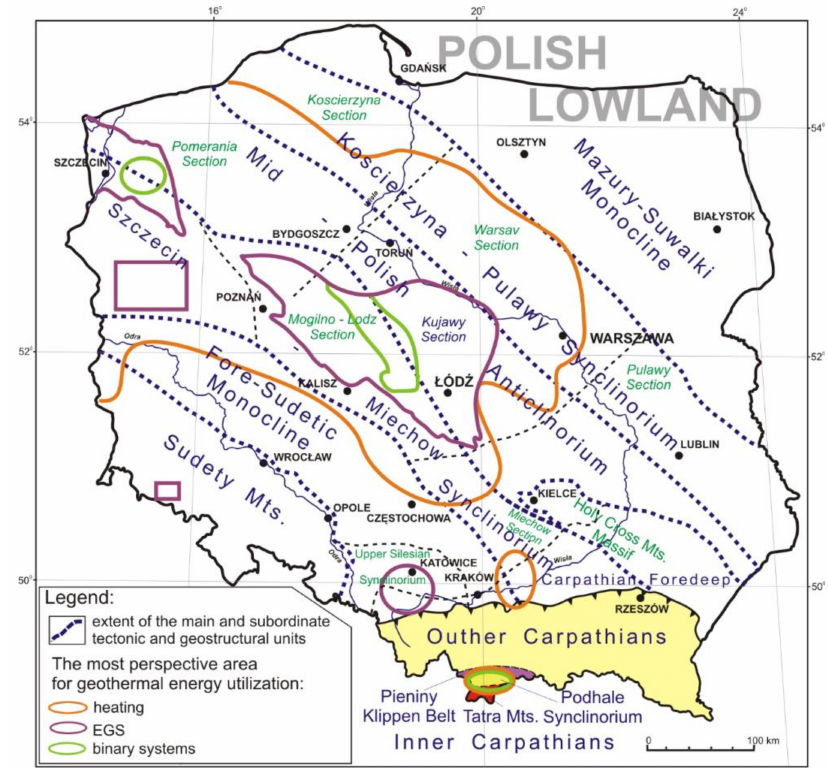
Figure 1. Tectonic units of Poland under the Cenozoic cover with the most prospective areas for geothermal energy use in Poland [43]. Reproduced from [42], modified by